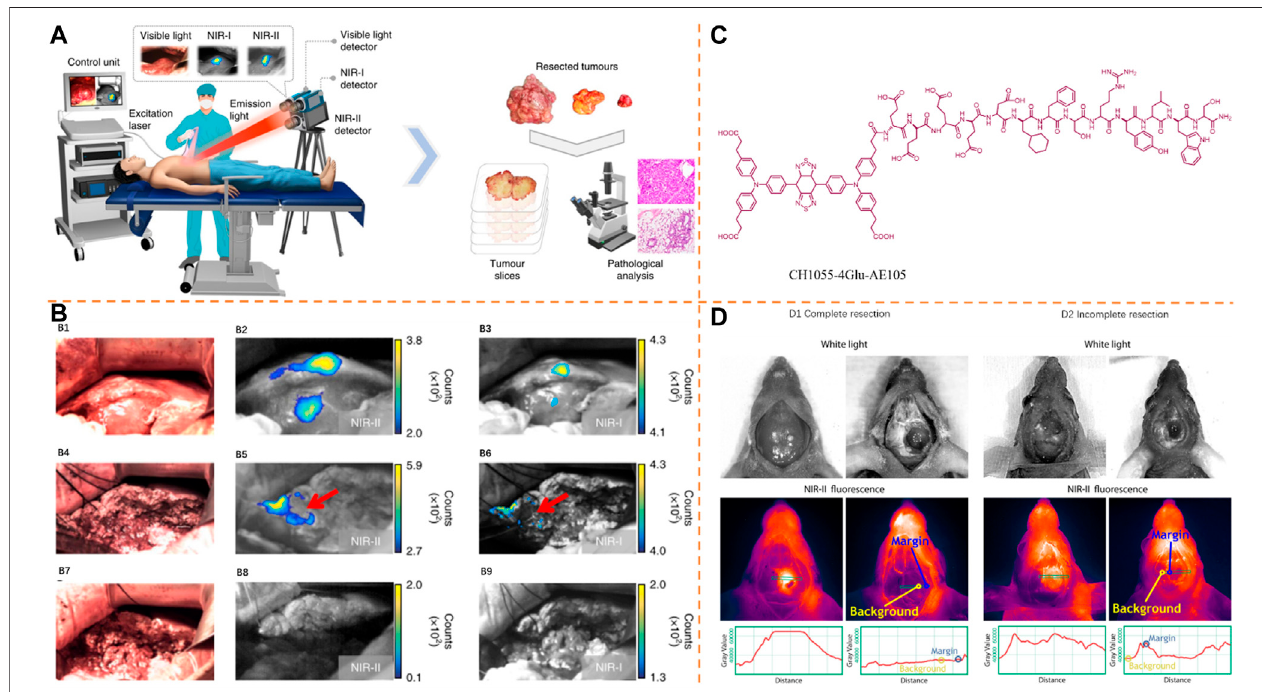
FIGURE7 |(A) In-human liver tumor surgery under the guidance ofmultispectral optical imagingin the visible and NIR-I/II windows. Adapted with permissionfrom Hu et al. (2020). (B) Intraoperative NIR-I/II fl uorescence image-guided tumor resection. (C) Peptide sequence and the systematic molecular construction of CH1055- 4Glu-AE105.AdaptedwithconsentfromKurbegovicetal.(2018). (D) Forbothfullresection (D1) andinadequateresection (D2) ,left-handendimagesweretakenbefore tumor resection and right-hand end images were taken after resection.